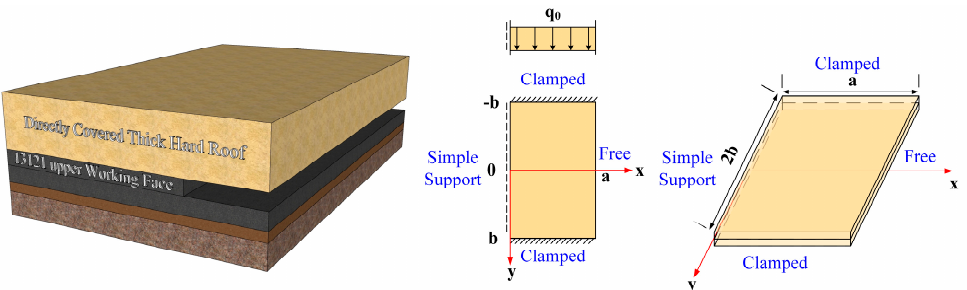
Figure 5. Mechanical model of the CSCF plate.